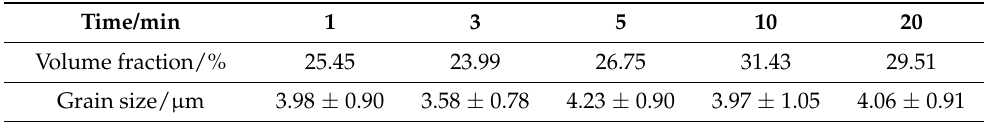
Table 2. Volume fraction and grain size of the primary α phase at different times.